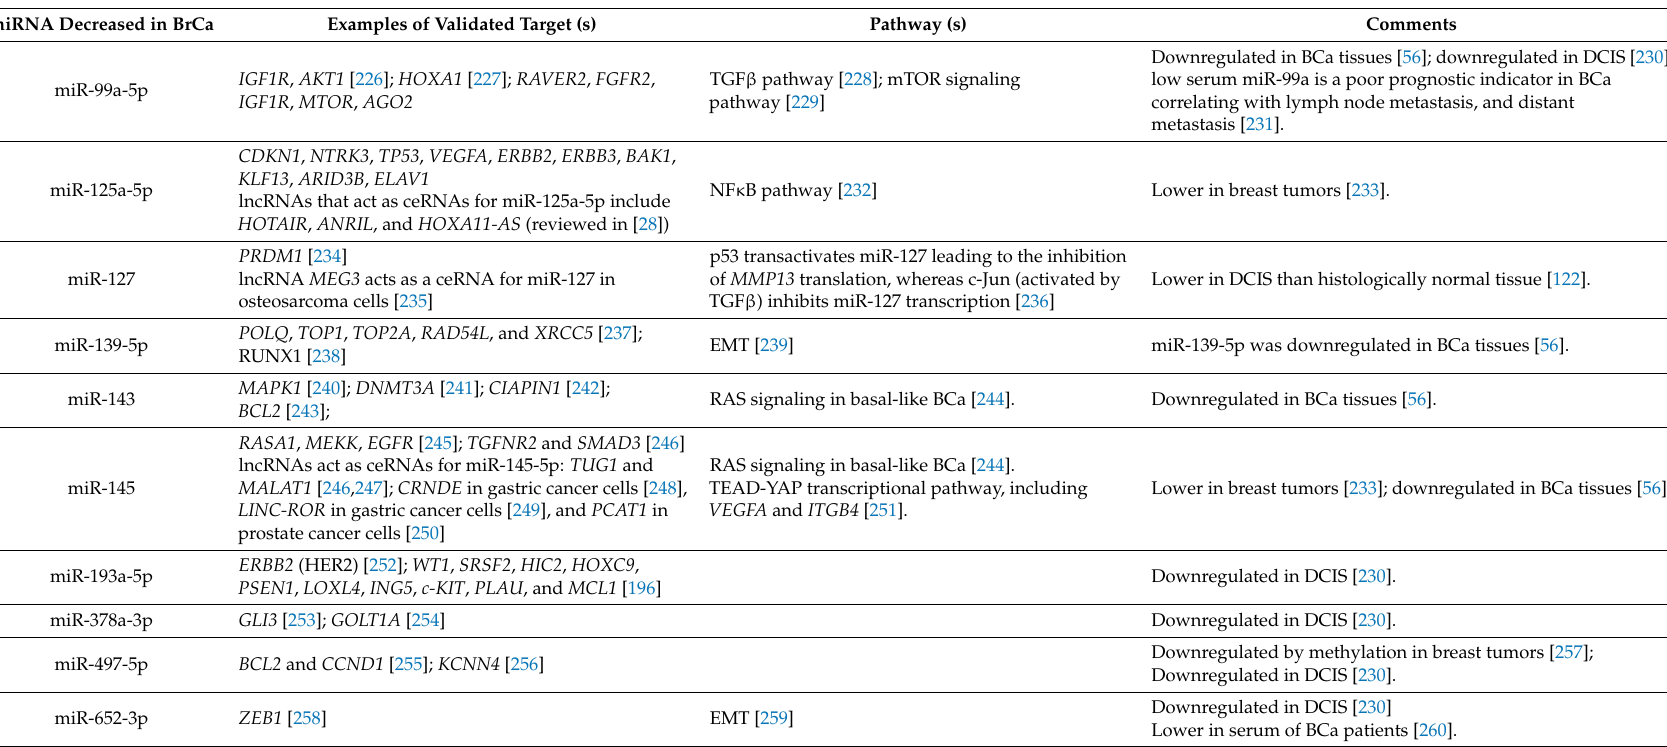
Table 3. Examples of miRNAs downregulated in breast tumors, patient plasma, and breast cancer cell lines with their authenticated targets. miRTarBase was used to identify validated targets not identified by reference